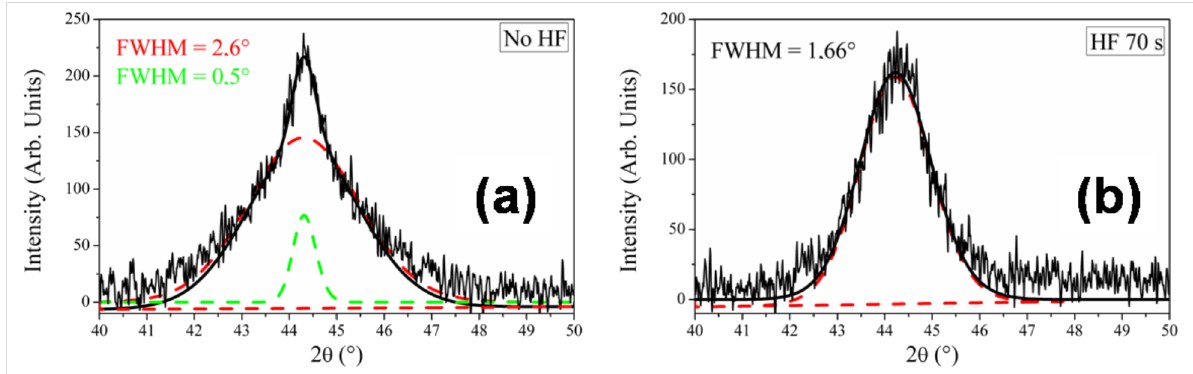
Figure 6: Au (200) peak as measured by XRD in Bragg–Brentano geometry of (a) as-deposited sample and (b) the same sample but after an HF treatment for 70 s.